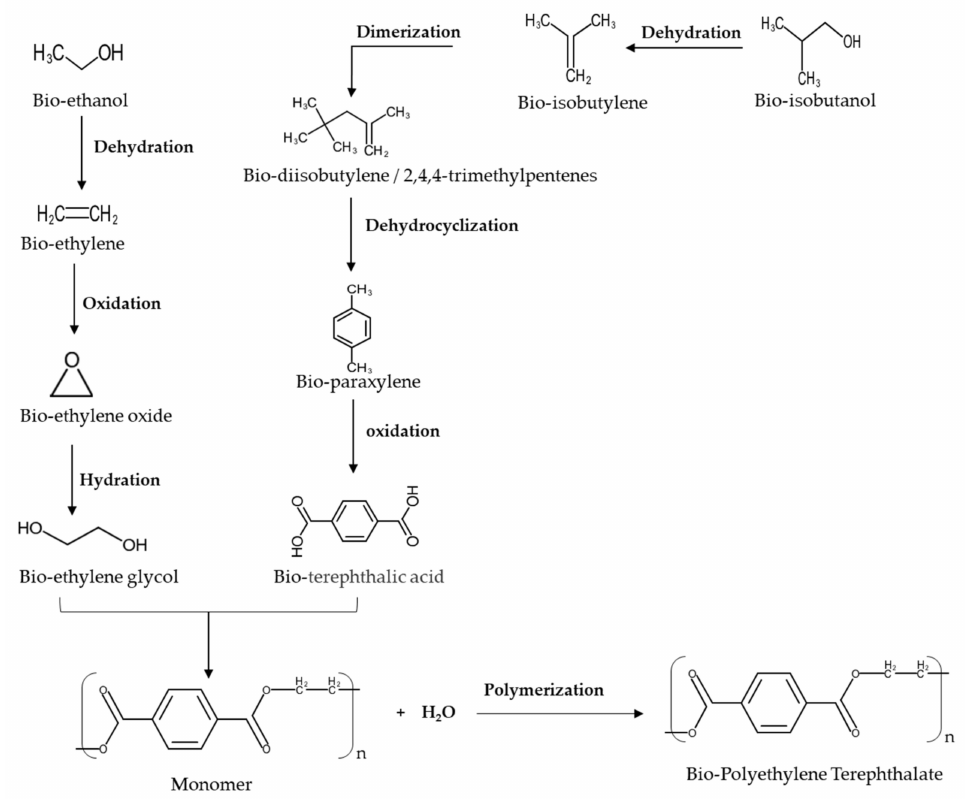
Figure 6. Reaction routes to